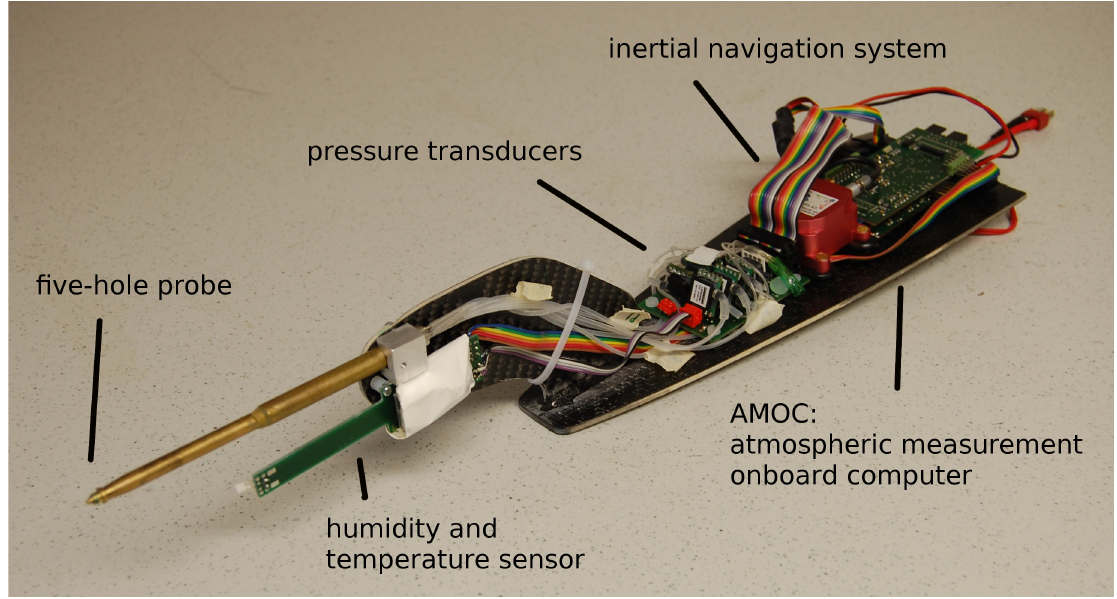
Figure 2. MASC measurement system with five-hole probe, capacitive humidity sensor and temperature sensor, pressure transducers, inertial navigation system (INS), and the measurement computer AMOC. The standard sensor system developed for the MASC is self-sufficient and can be mounted on other airframes. To cover circular flight patterns, which are often used by flying wings like SUMO, or the return glider radiosonde (RGR, see [5]), data from a measurement campaign at the Boulder Atmospheric Observatory (BAO) were included: A commercially available flying wing (Skywalker X8) with a span of 2.1 m and a take-off weight of about 3.5 kg was equipped with the MASC sensor system and flown at the BAO. Figure 3 shows the Skywalker X8 flying wing with the sensor nose as used with the MASC. This sUAS is equipped with a Black Swift Technologies LLC (Boulder, CO , USA) autopilot system which maintains the airspeed, using a pitot-static tube, at 22 m s − 1 .